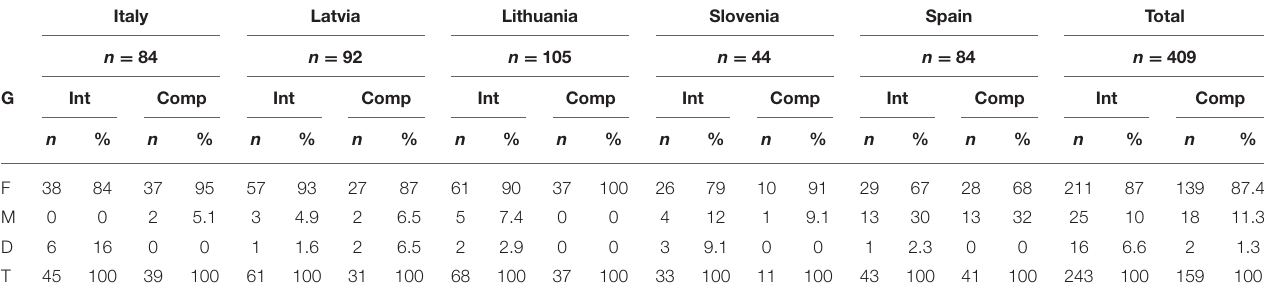
TABLE 1 | Number of teachers according to gender in all participating countries and in total.